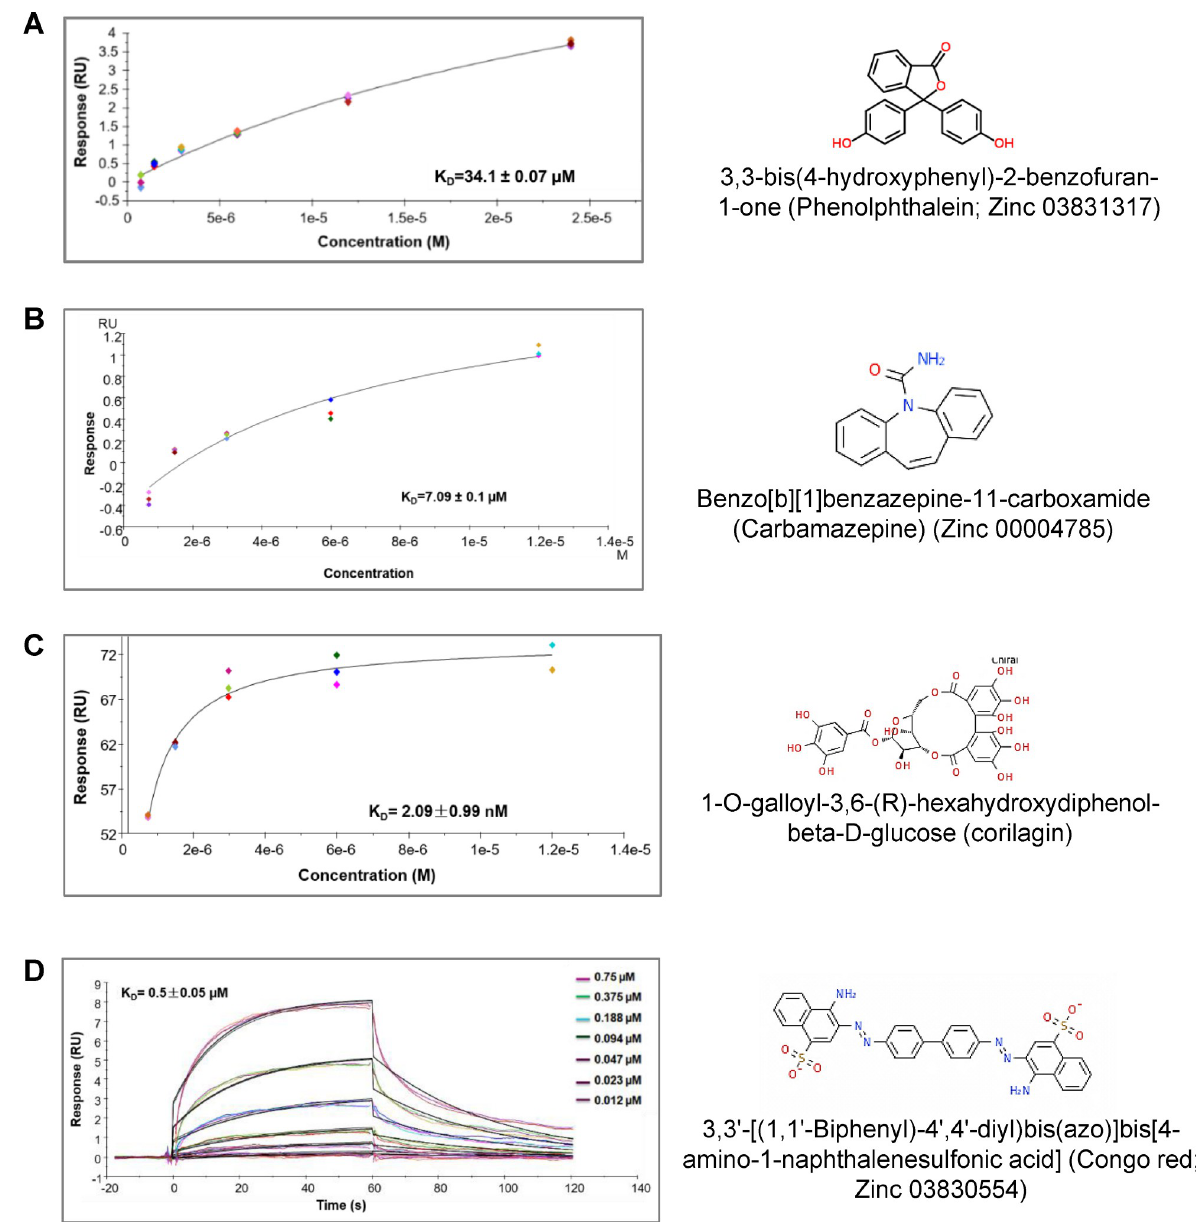
Fig 1. Screening of small molecules for direct binding to Pol γ by SPR technology. (A-D) SPR binding kinetics of computationally predicted small molecules to Pol γ . Sensorgrams show the interaction between compounds and Pol γ at different concentrations and K D values. All data are presented as the means ± standard deviation (STD) of three independent experiments. The chemical structures of small molecules are given. the activity of Pol γ about 15.6%, 11.19%, and 15.88%, respectively. We observed that not every small molecule bound to Pol γ protein affected its DNA synthesis activity. This might be because the region of the Pol γ protein interacting with these small molecules did not affect its strand displacement activity. Of the molecules tested, CR showed the greatest inhibition (about 98%) on the strand displacement activity of Pol γ at 20 μ M (Fig 2B, lane 4, molecule no 1).